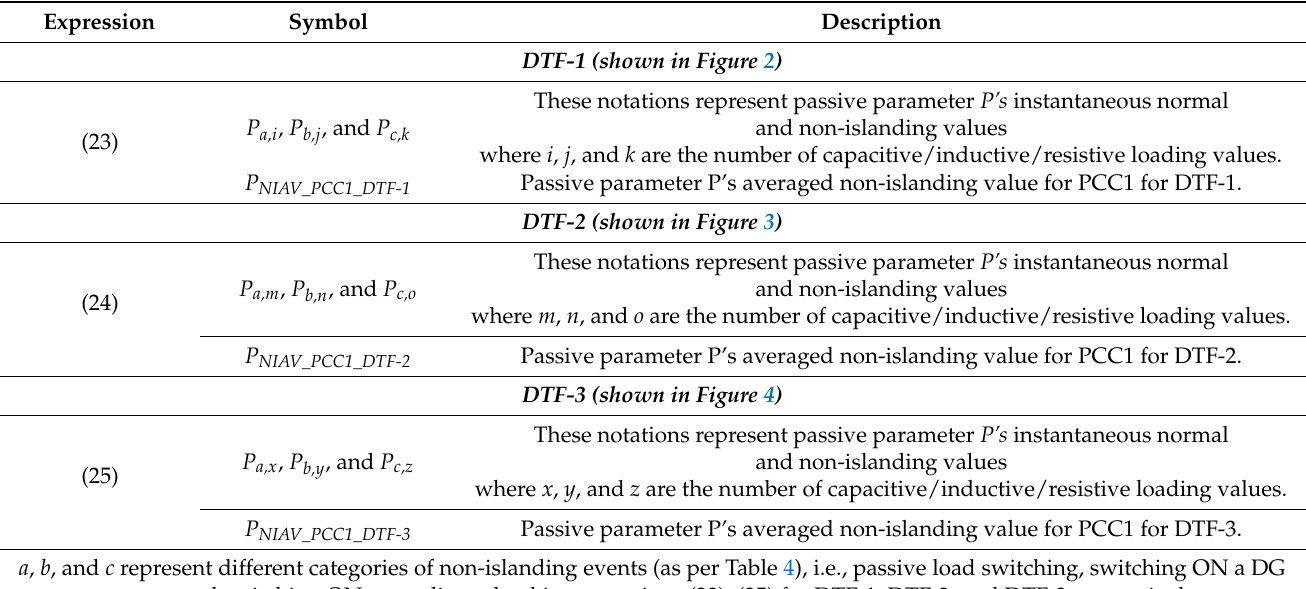
Table 6. Description of symbols used in the expressions for computation of the averaged non- islanding